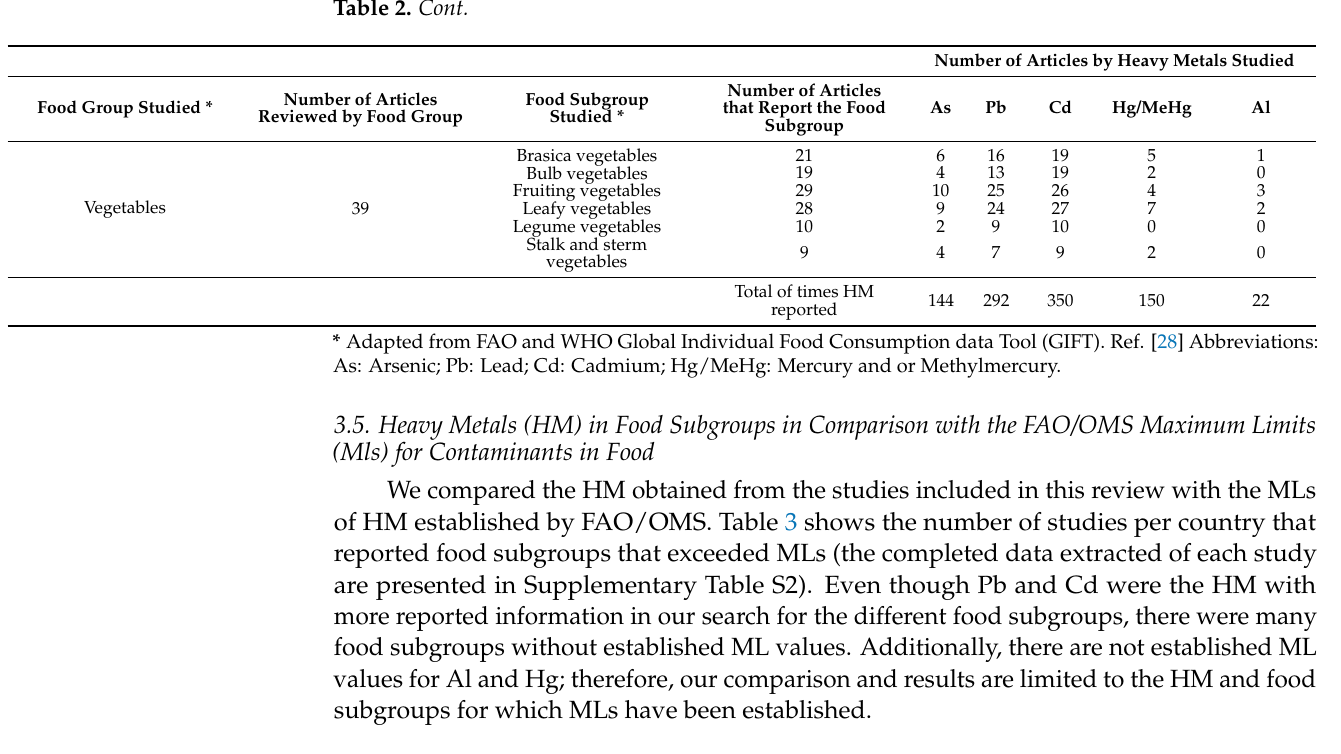
Table 3. Number of articles that reported food subgroups that exceeded the Maximum Limits of heavy metals established by FAO/OMS per